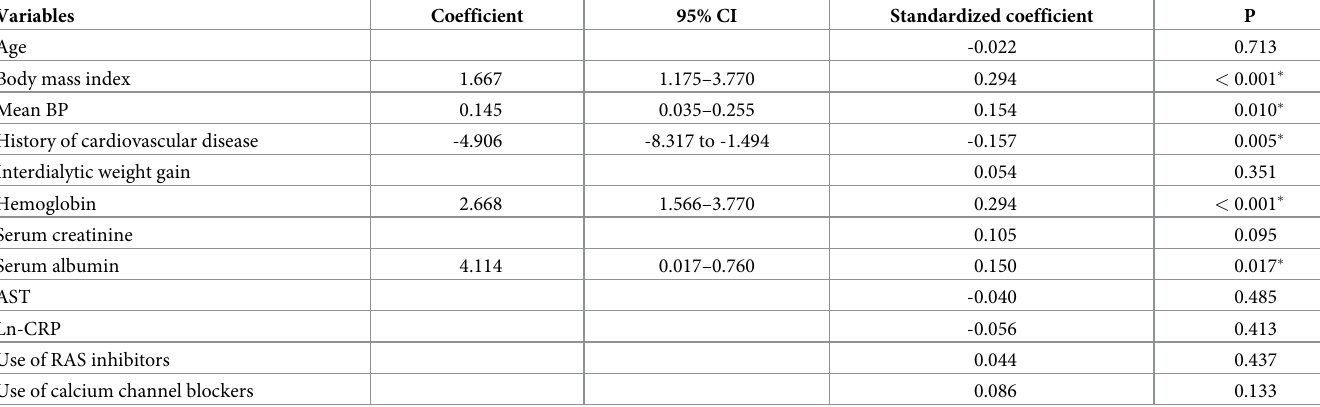
Table 2. Multivariable linear regression analysis in Model 1 using serum albumin: Factors independently associated with hepatic rSO 2 in patients undergoing HD.